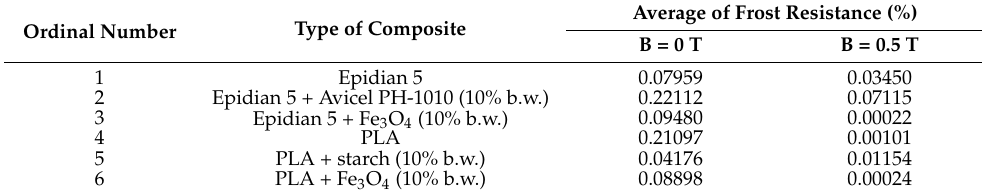
Table 7. Frost resistance of